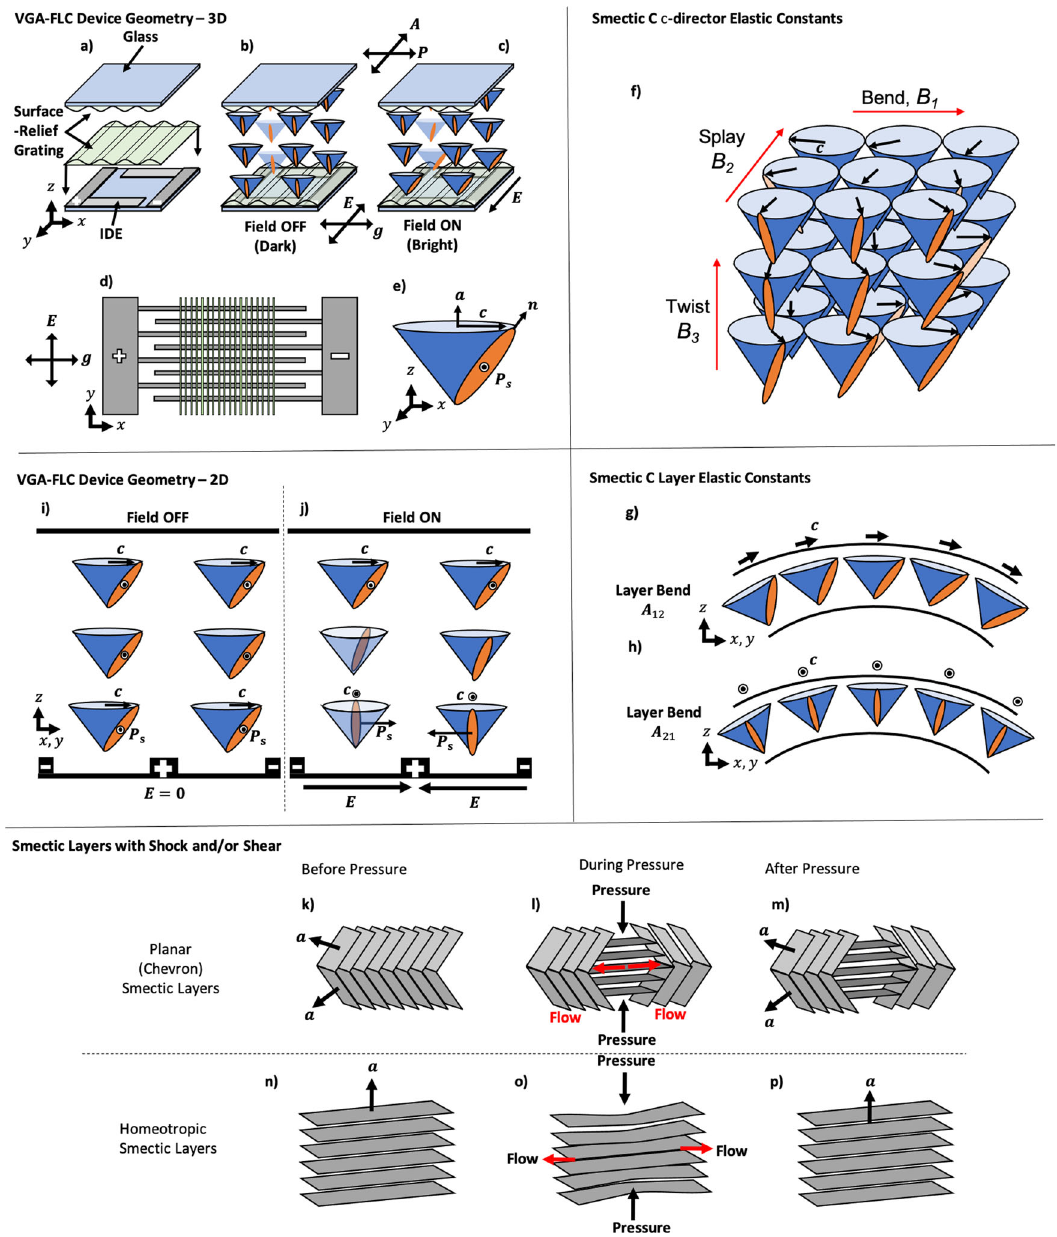
Fig. 1 The geometry of the vertical grating-aligned ferroelectric liquid crystal device (VGA-FLC). a – e Schematic diagrams and operating principles of the VGA-FLC device geometry. a 3D schematic of the surface relief grating and its arrangement with respect to the interdigitated electrode (IDE). b Device with no applied electric fi eld (OFF/dark state), where the c -director is aligned homogeneously through the cell. c Schematic of the effect of applying an electric fi eld across the IDE to rotate the c -director 90° at the lower surface and therefore a twisted con fi guration through the cell. On removal of this fi eld, the device relaxes to the homogeneous c -director pro fi le of ( b ). d Plan view of the grating orientation with respect to the IDE. e De fi nitions for the FLC c - director, n , and the spontaneous polarisation, P s . f – h De fi nitions of the c- director elastic constants. f Shows c -director bend (B 1 ), splay (B 2 ), and twist (B 3 ) for uniform layers. g and h Show the possible orientations of the c -director with respect to a sinusoidal undulation of the smectic layer normal a in a SmC phase. In either case, the solution shown is accompanied by a second possibility with the c director at 180°. Shown are one of the two solutions for ( g ) c ⊥ g , when A 12 « A 21 ; and ( h ) c || g , when A 12 » A 21 . i and j A 2D schematic of the fi eld on either side of an IDE where ( i ) has no applied fi eld, and ( j ) has an applied fi eld twisting the c -director by 90° through the cell in opposite direction across the electrode. k – p The response of both planar and homeotropic oriented smectic layers when exposed to a mechanical shock, where a is the layer normal. When initially in a planar orientation ( k ), pressure disrupts the orientation of the layers to a homeotropic alignment geometry in the affected region ( l ), which remains after force removal ( m ). In the homeotropically aligned state ( n ) the layers compress, resulting in compression and therefore in-plane fl ow of the FLC ( o ), withstanding signi fi cant disruption to the alignment of the smectic layers ( p ).